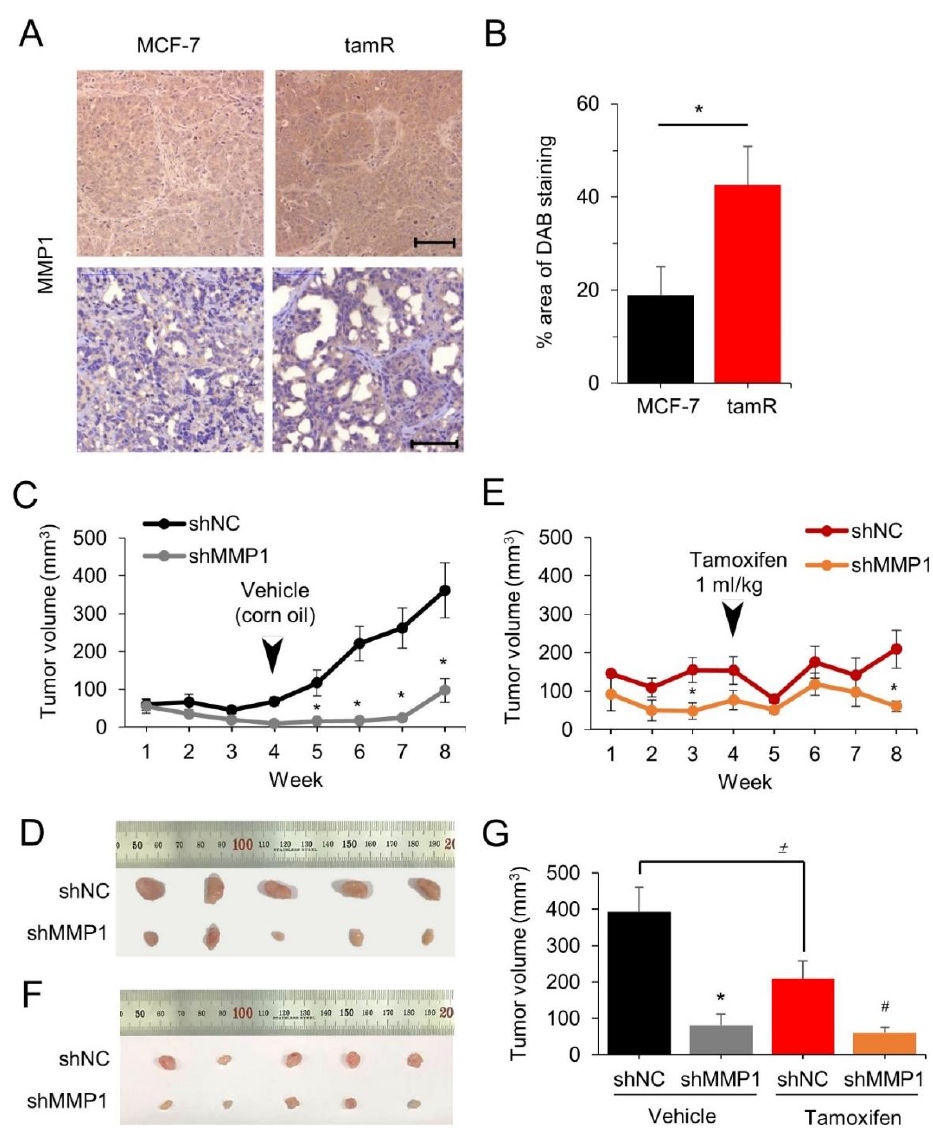
Figure 4. Downregulating MMP1 inhibits tumor growth and induces tam sensitivity in xenografted mice. ( A ) Immunohistochemical analysis of MMP1 expression was conducted on xenografted tumor tissues containing MCF-7 and MCF-7/tamR cells. Three tissue sets were analyzed, and the protein expression is depicted in the bar graph ( B ). Representative images are shown. Scale bar, 100 μm. MCF-7/tamR cells stably transfected with shMMP1 or shNC were subcutaneously injected into BALB/c nude mice. The tumor volume was examined every week for eight weeks. Corn oil ( C ) or Tam ( E ) was administered according to intraperitoneal method after 3 weeks of cell transplantation. At week 8, mice were sacrificed to extract untreated ( D ) and tam-treated tumor tissues ( F ), of which size is denoted in a bar graph ( G ). n = 5 for each group. * p < 0.05 versus shNC control; # p < 0.05 versus shNC tam; ± p < 0.05.